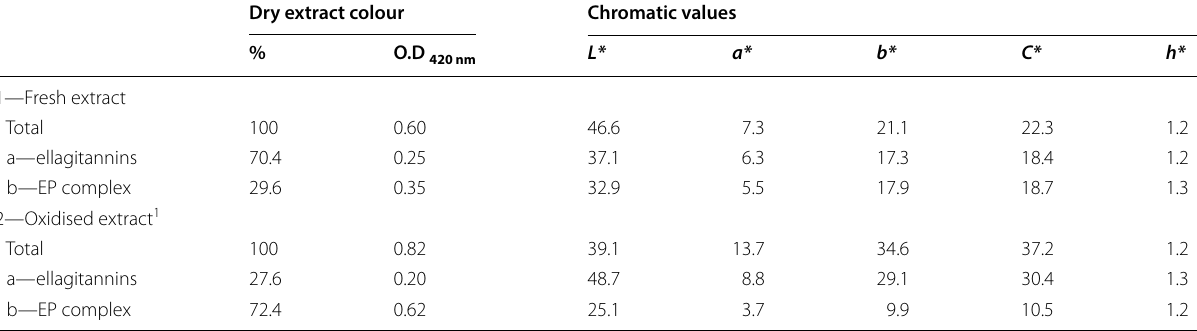
Table 2 In vitro model of ellagitannins chemistry during duraminisation process: influence of oxidation (1 vs. 2) 1 ; influence of association of oxidised ellagitannins and polysaccharides ( a vs. b ) 2 (initial extract from acetone/water (7/3, v/v) extraction of Q. robur outer